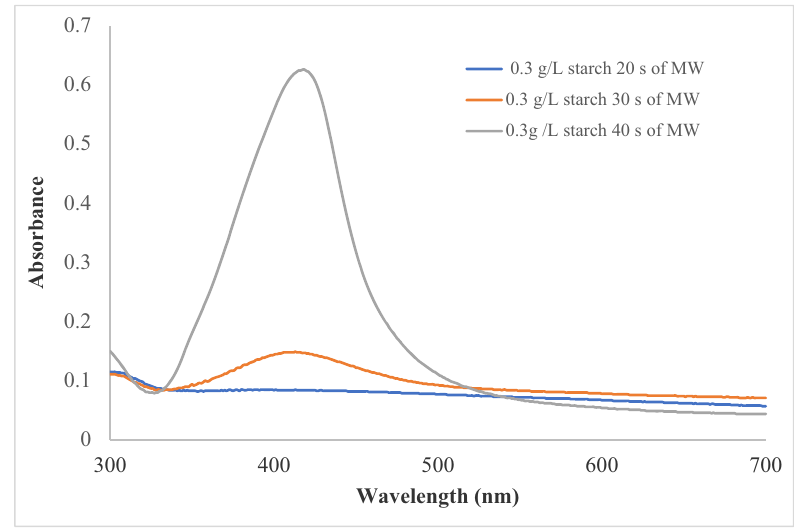
Figure 2: UV – Vis spectra of AgNPs synthesized using 2.5 g · L − 1 of AgNO 3 at di ff erent exposure times at microwave heating.